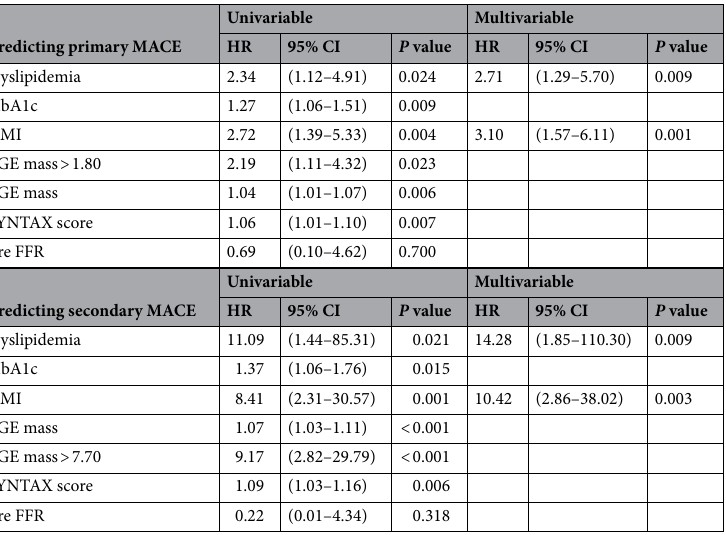
Table 3. Predictors of primary and secondary MACE (Cox proportional hazard model). Abbreviations are in Tables 1 and 2. LGE = late gadolinium enhancement; primary MACE was defined as cardiovascular death, nonfatal MI, hospitalization for congestive heart failure, unplanned late revascularization, and ischemic stroke. secondary MACE was defined as cardiovascular death, nonfatal MI, hospitalization for congestive heart failure, and ischemic